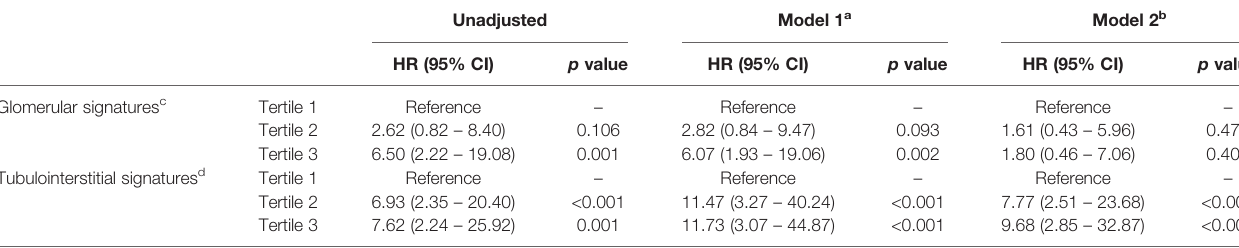
TABLE 4 | Hazard ratios of compartmental mRNA signatures for renal